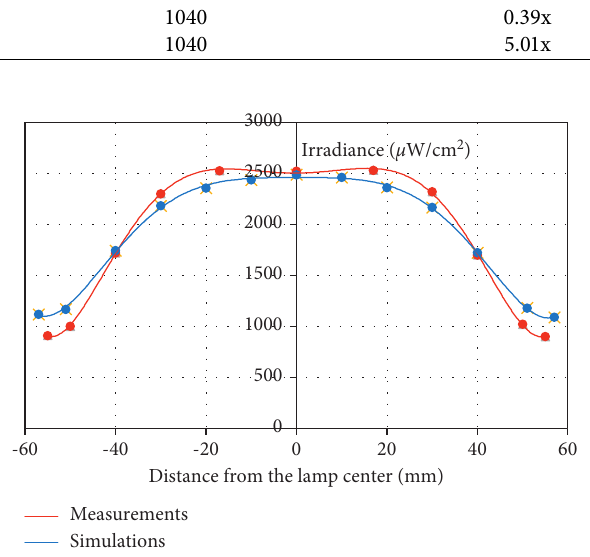
Figure 7: Irradiance measurements from the enclosure wall through the length of the enclosure.